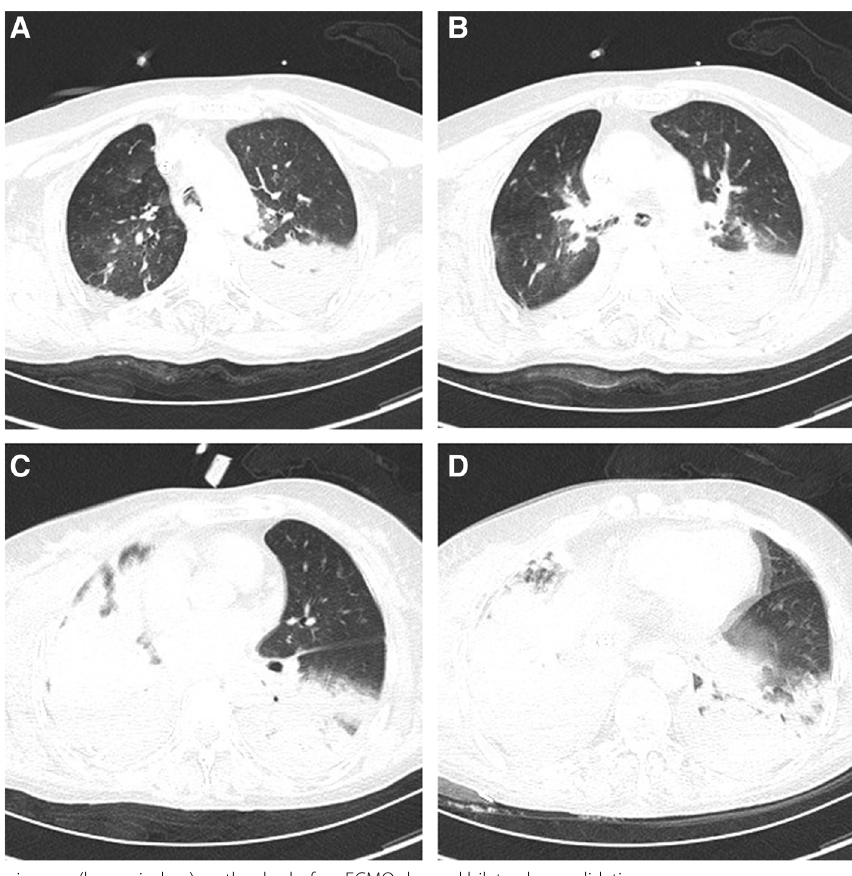
Fig. 3 Chest CT scan images (lung window) on the day before ECMO showed bilateral consolidation